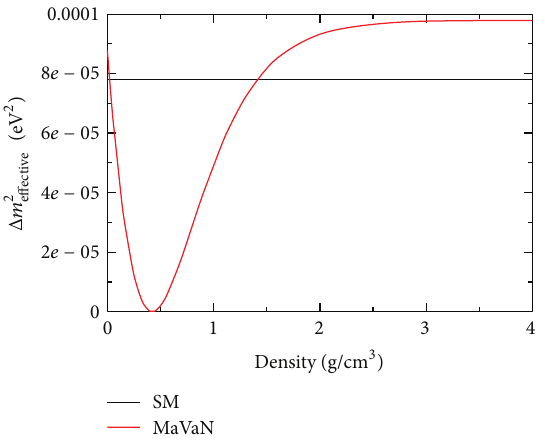
Figure 3: Correlation between the effective value of mass after the inclusion of the effect MaVaN and the same term with only the parameters of the standard model.